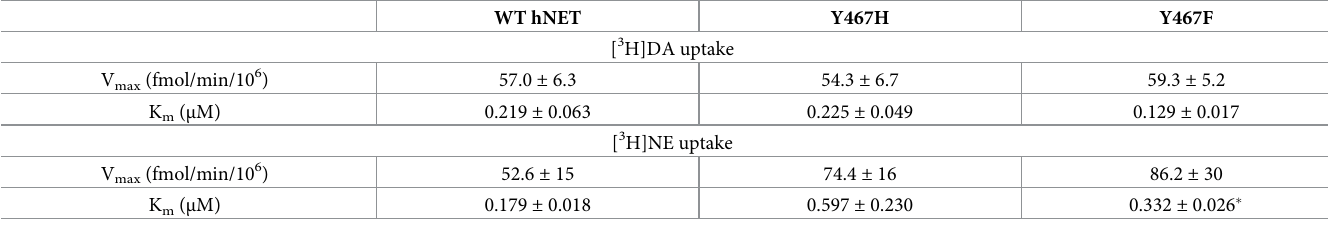
Table 1. Kinetic properties of the reuptake of [ 3 H]DA and [ 3 H]NE in PC12 cells expressing WT hNET and its mutants.